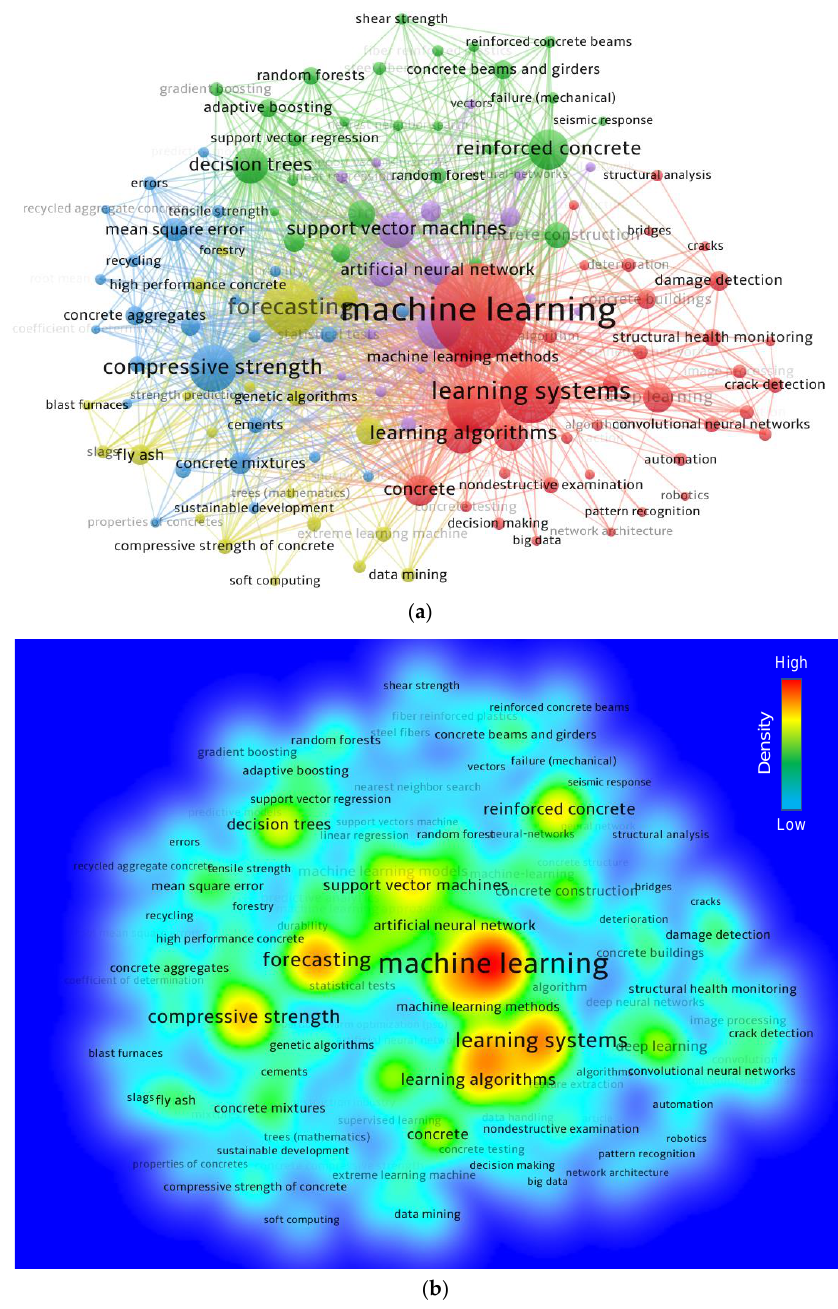
Figure 7. Systematic map of keywords: ( a ) scientific mapping; ( b ) density.